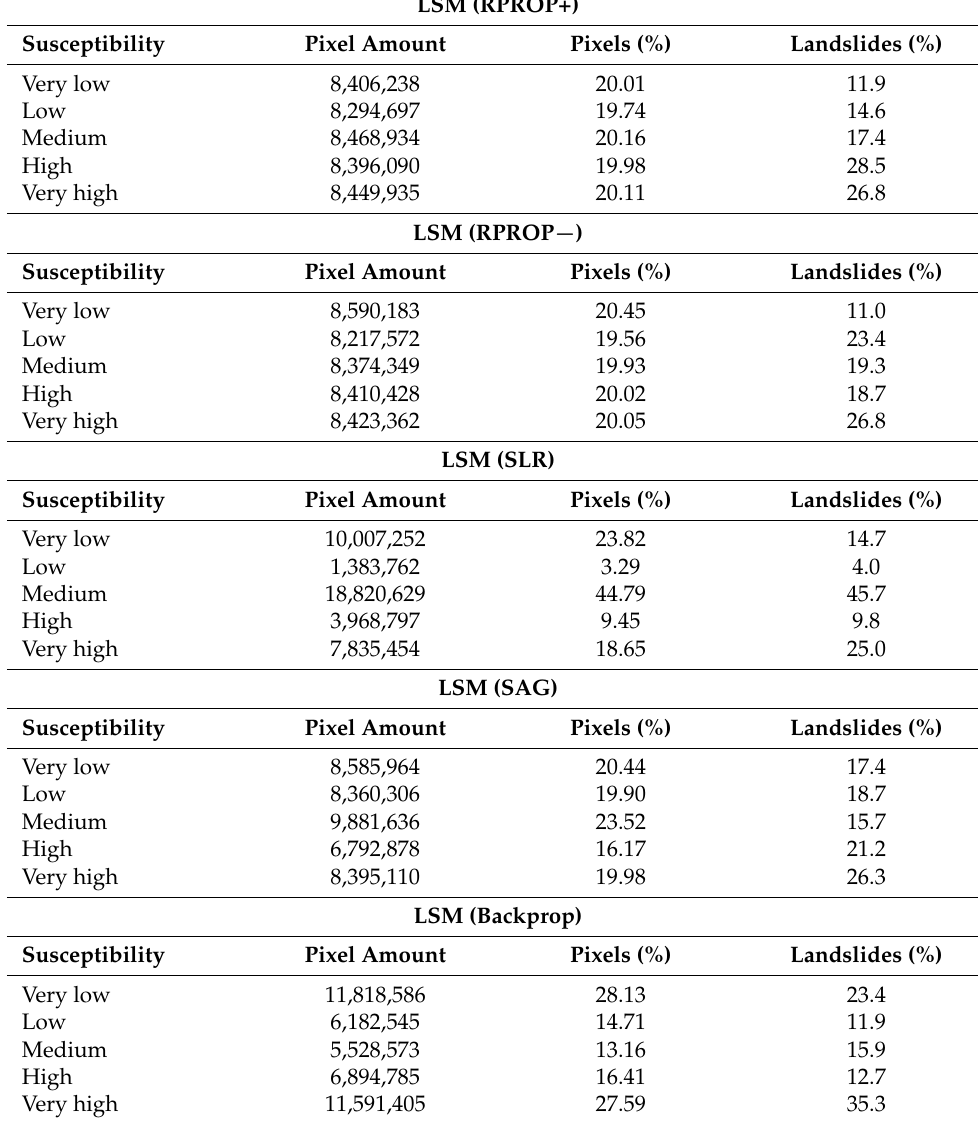
Table 10. Susceptibility classes per algorithm and percentage of landslides per